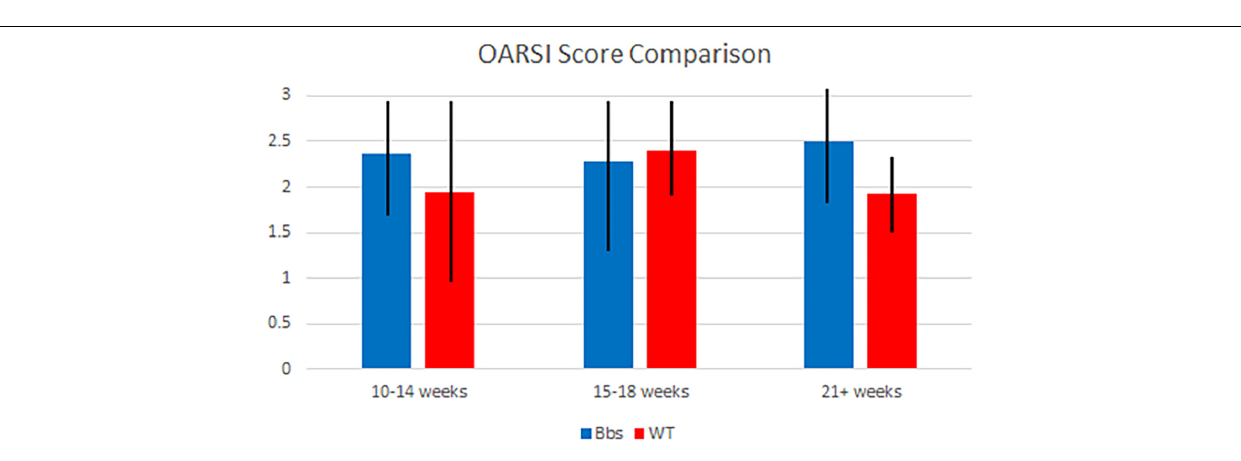
FIGURE 3 | OARSI score comparison of Bbs1 M390R/M390R mutant and WT mice at various ages. Articular cartilage degradation from both mutant and WT samples was objectively evaluated using the OARSI scoring system by two blind scorers. Samples were combined into generalized age groups of 10–14 (WT n =